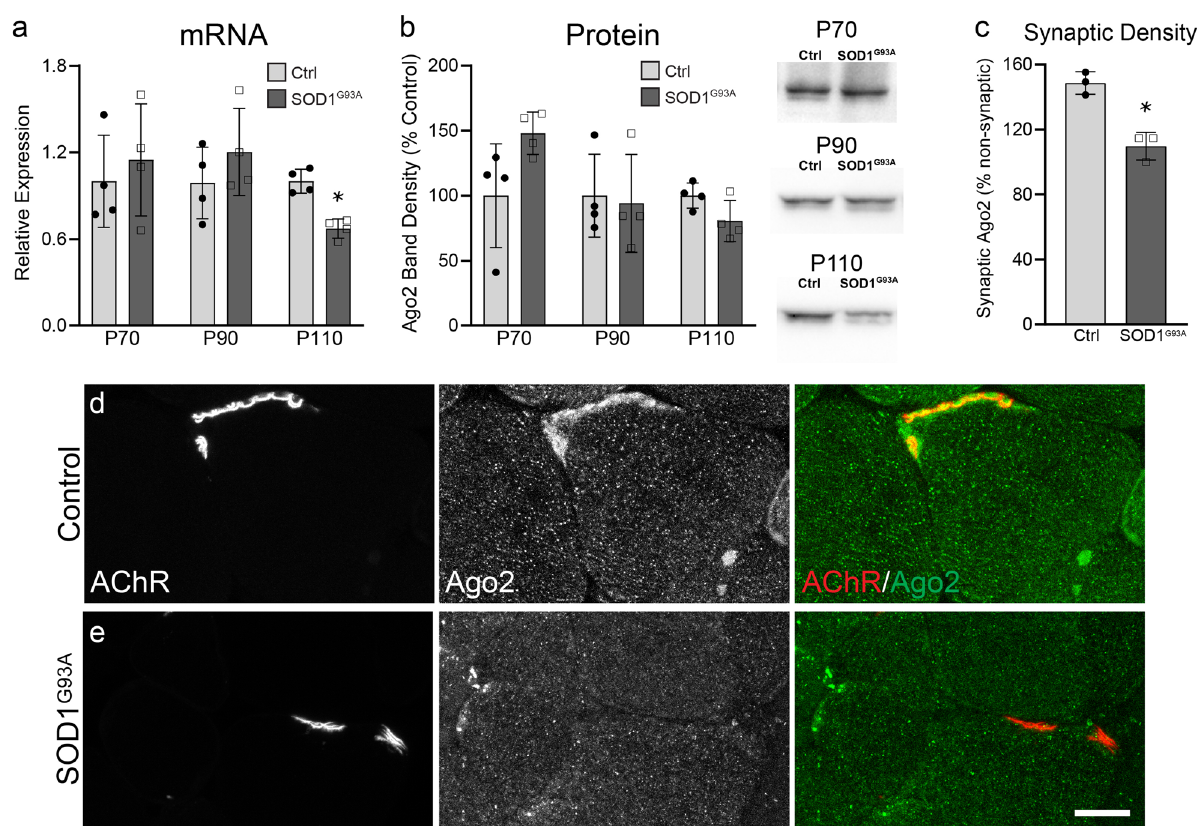
Figure 4. Ago2 expression and distribution are disrupted in SOD1 G93A muscle. ( a ) qPCR and ( b ) Western blot analysis of Ago2 levels in TA muscle collected from P70, P90, and P110 SOD1 G93A and control littermates (N = 4). mRNA levels are relative to age-matched controls. Protein levels are normalized to total protein (Fig. S7c,f,i). Images are cropped from the full-length blot, available in Fig. S7. ( c ) Mean synaptic Ago2 pixel intensity in TA muscle fibers of P90 SOD1 G93A and control littermates, reported as the ratio of synaptic versus non-synaptic pixel intensity within a muscle fiber (N = 3). ( d , e ) Representative images of Ago2 (green) distribution at fBTX-labeled NMJs (red) in TA cross sections of P90 control ( d ) and SOD1 G93A ( e ) littermates. *p < 0.05, versus age-matched control, unpaired 2-sided T-test. All values reported as mean ± SD; n = 4 for all panels except C, where n = 3. Scale bar = 10